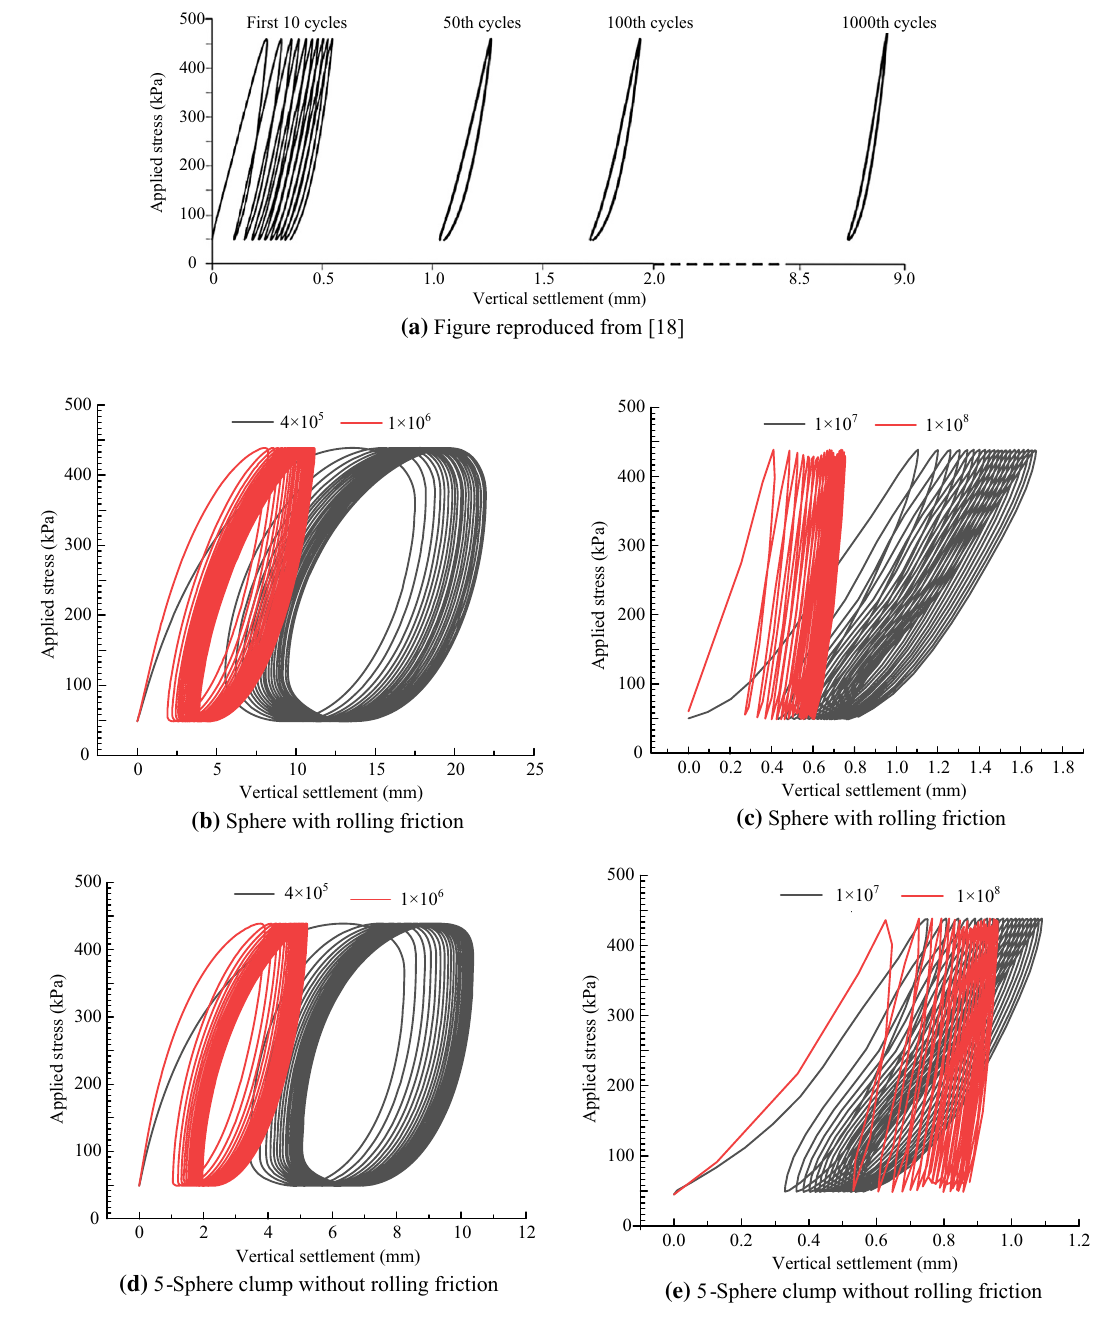
Fig. 11 Applied stress vs vertical displacement in the first 15